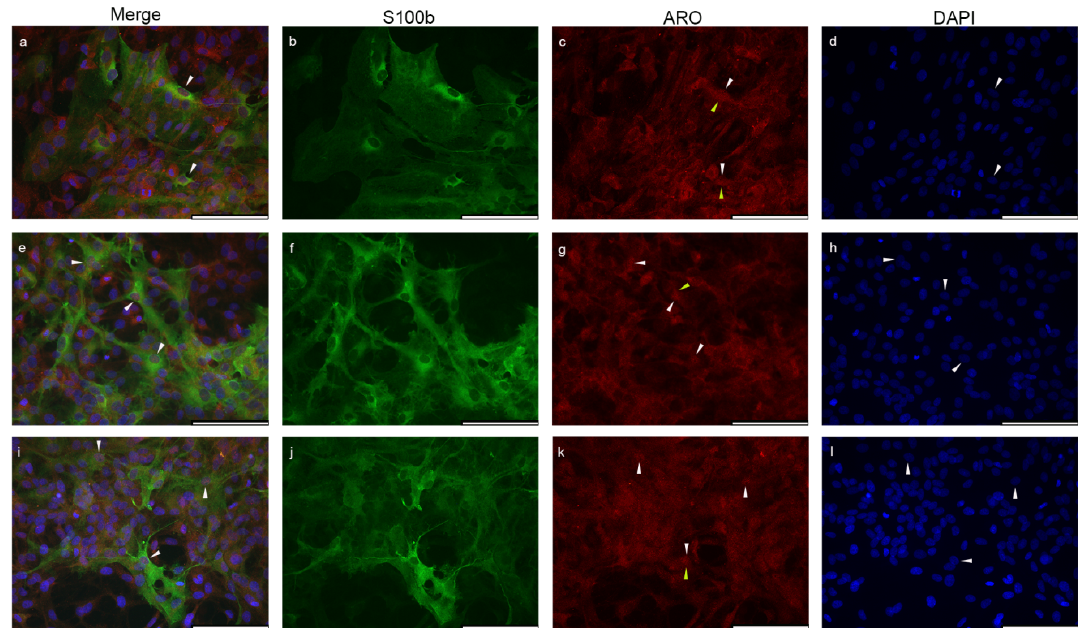
Figure 3. Nuclear colocalization of Aro in S100 β positive cells from P0–P5 newborn rats. The three individual sets of pictures ( a – l ) show that Aro (red) is also expressed in S100 β -positive astrocytes (green) in glial cell culture. Aro immunopositivity is detectable in the close perinuclear cytoplasmic area ( c , g , k ; yellow arrowheads) and also colocalizes ( a , c , e , g , i , k ; white arrowheads) with the nuclear signal (blue). Scale bar: 100 µ m.